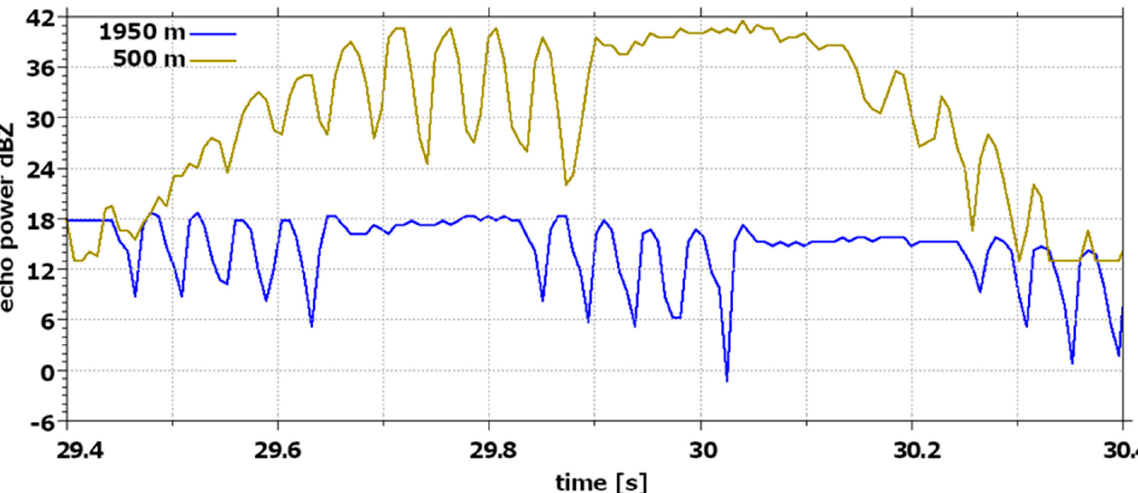
Figure 7. High temporal resolution recordings of migrating birds, as observed by the vertical-look-ing Doppler weather radar at Järvenpää, 32 km NNE from Kumpula radar, on 5 October 2007, 17:35:29.6–17:35:30.4 UTC. The figure covers a one-second period. The birds were observed simul-taneously at 500 and 1950 m traversing the vertical-looking radar beam.